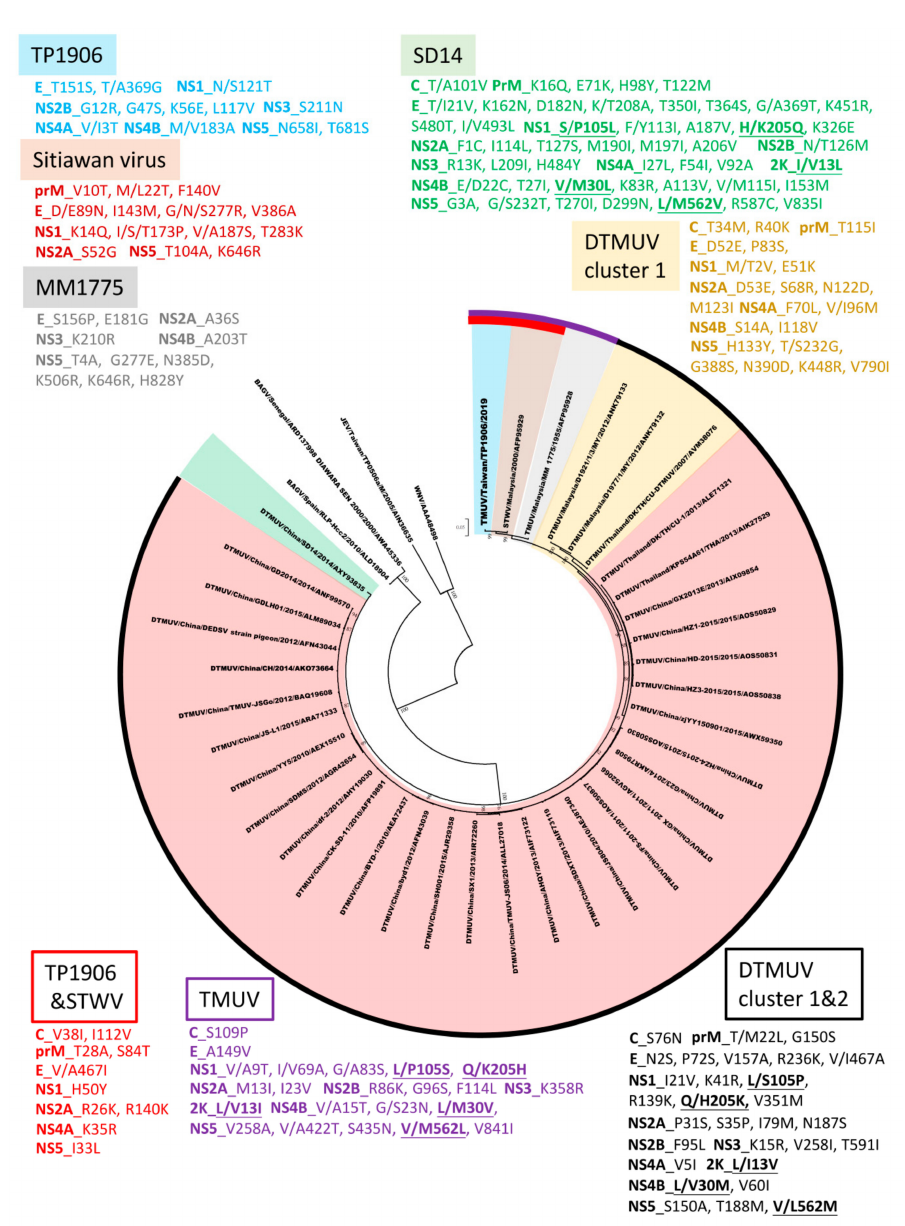
Figure 4. Phylogeny of TMUV-TP1906, Tembusu virus strains (TMUVs), and duck Tembusu virus strains (DTMUVs) based on the polyprotein amino acid sequences (3425 aa). The evolutionary history was inferred by using the maximum likelihood method based on the JTT matrix-based model [23]. The tree with the highest log likelihood is shown. Initial tree(s) for the heuristic search were obtained automatically by applying Neighbor-Join and BioNJ algorithms to a matrix of pairwise distances estimated using a JTT model, and then selecting the topology with superior log likelihood value. The tree is drawn to scale, with branch lengths measured in the number of substitutions per site. The analysis involved 40 amino acid sequences. All positions containing gaps and missing data were eliminated. Evolutionary analyses were conducted in MEGA7 [21]. The reliability of the analysis was calculated using 1000 bootstrap replication. Bootstrap support values > 75 are shown. The scale bar indicates amino acid substitutions per site. The unique amino acid residues in TP1906, Sitiawan virus, MM1775, SD14, and DTMUV cluster 1 compared to other TMUV strains were colored in blue, brown, gray, green, and yellow, respectively. The unique amino acid residues in DTMUV cluster 1 and 2, TMUV lineage, and TP1906 and STWV compared to other TMUV strains were colored in black, purple, and red,